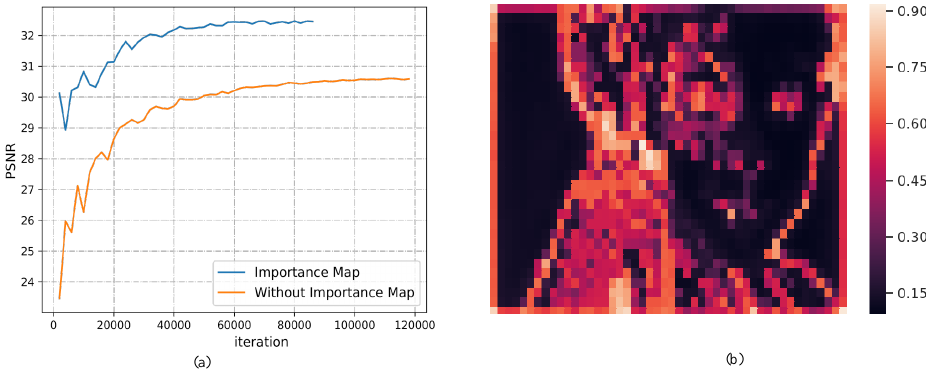
Figure 9. ( a ) PSNR performance during the training phase and the process of residual learning at about 0.47 BPP; amd ( b ) importance map of image kodim15 in Kodak dataset.